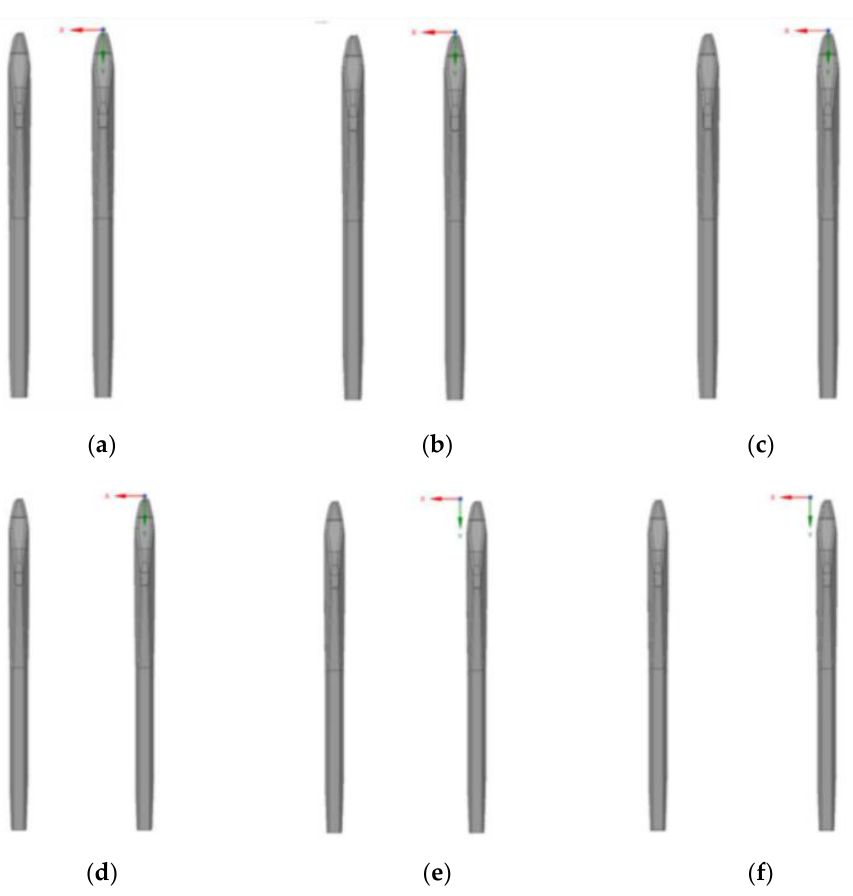
Figure 5. Initial float clearance configuration: ( a ) 0.20; ( b ) 0.25; ( c ) 0.30; ( d ) 0.35; ( e ) 0.40 ; and ( f ) 0.45.